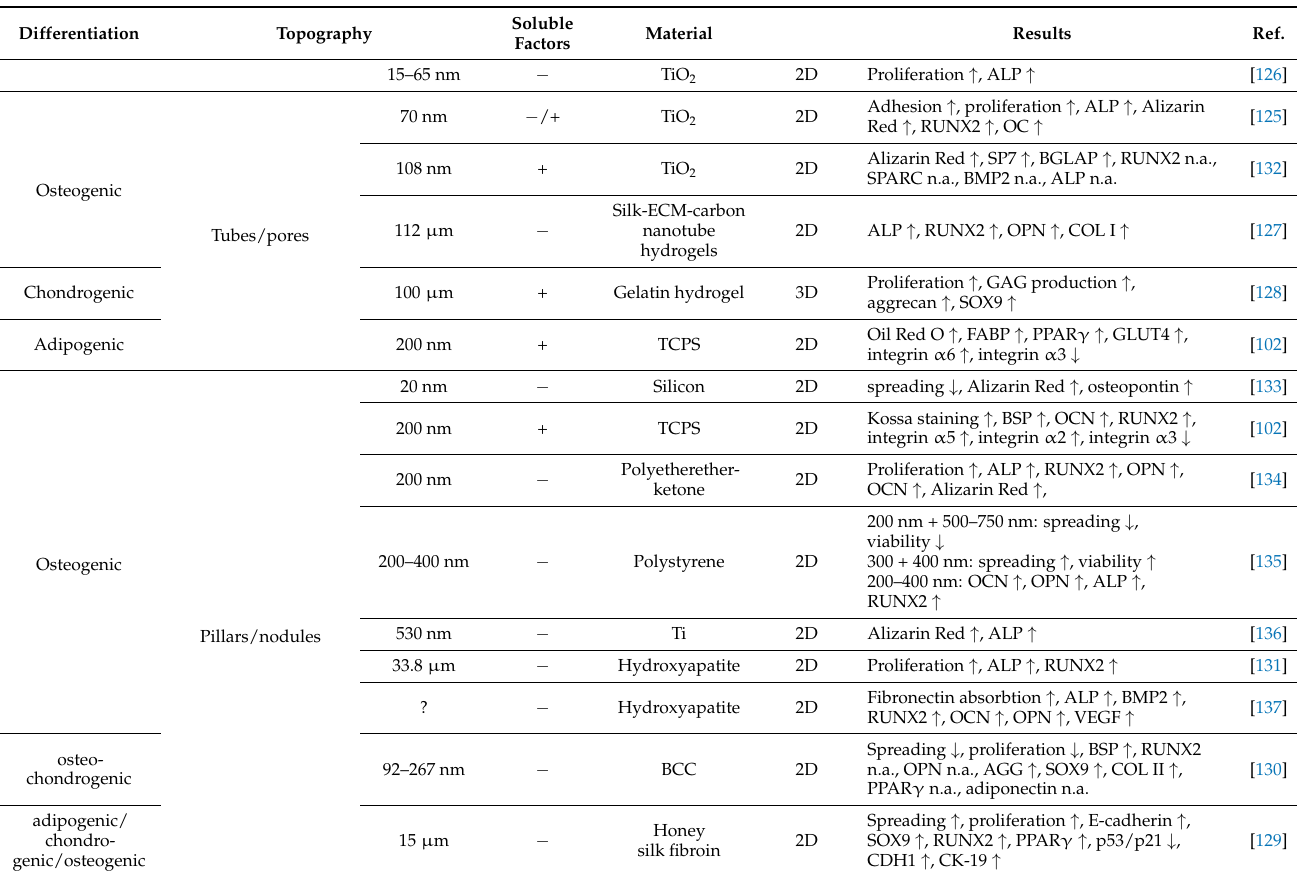
Table 3. Overview of the influence of tubes/pores, pillars, and nodular structures on ASCs. (TiO 2 : titanium oxide, ECM: extracellular matrix, TCPS: tissue culture polystyrol, BCC: binary colloidal